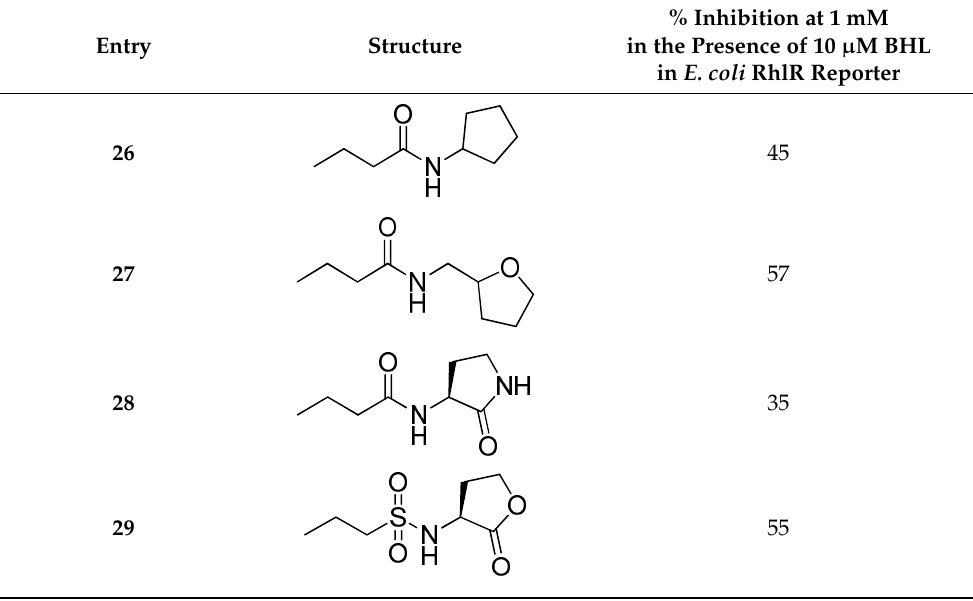
Table 3. RhlR-targeted antagonists.